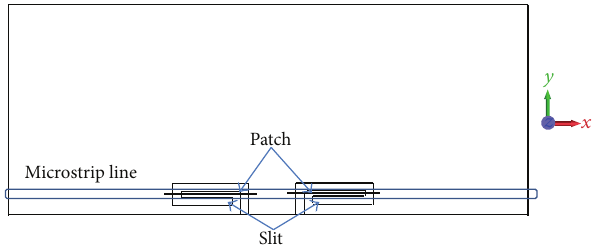
Figure 4: Two identical double-layered structures implemented on the ground plane.